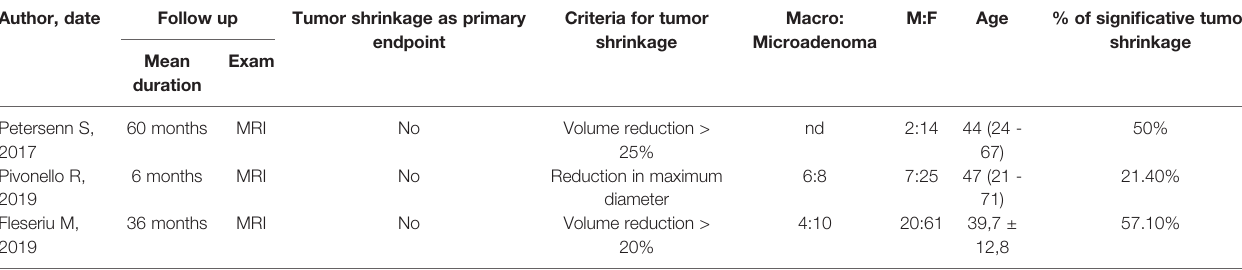
TABLE 4 | Studies considered for the metanalysis in Cushing ’ s Disease.